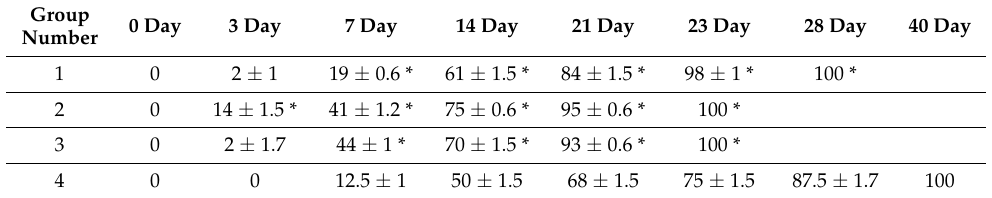
Table 3. Dynamics of the healing process. The standard deviation values for 5 measurements are indicated. * indicates statistically significant differences between experimental and control